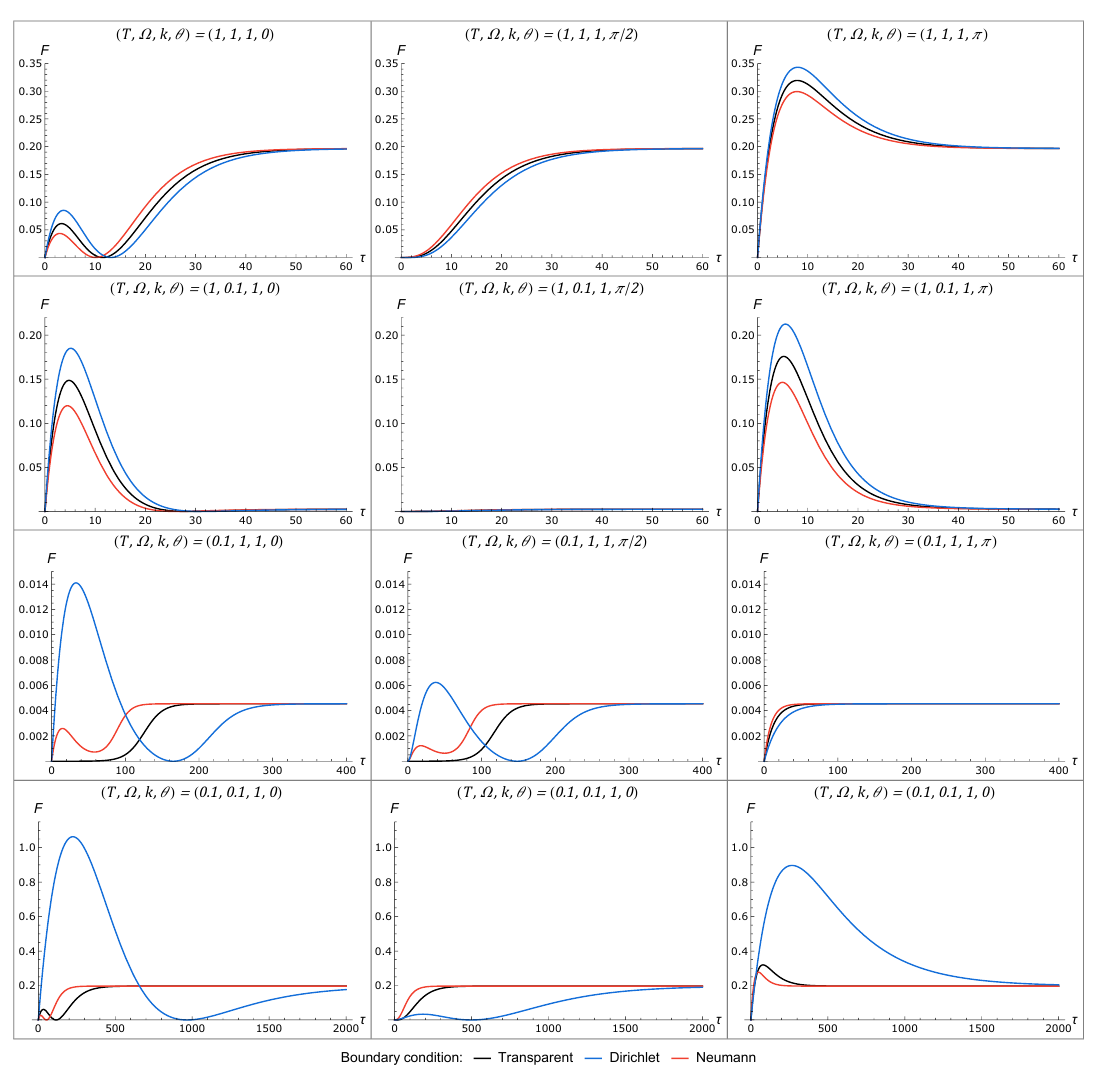
Figure 6 . The effect of different boundary conditions on the Fisher information in AdS 4